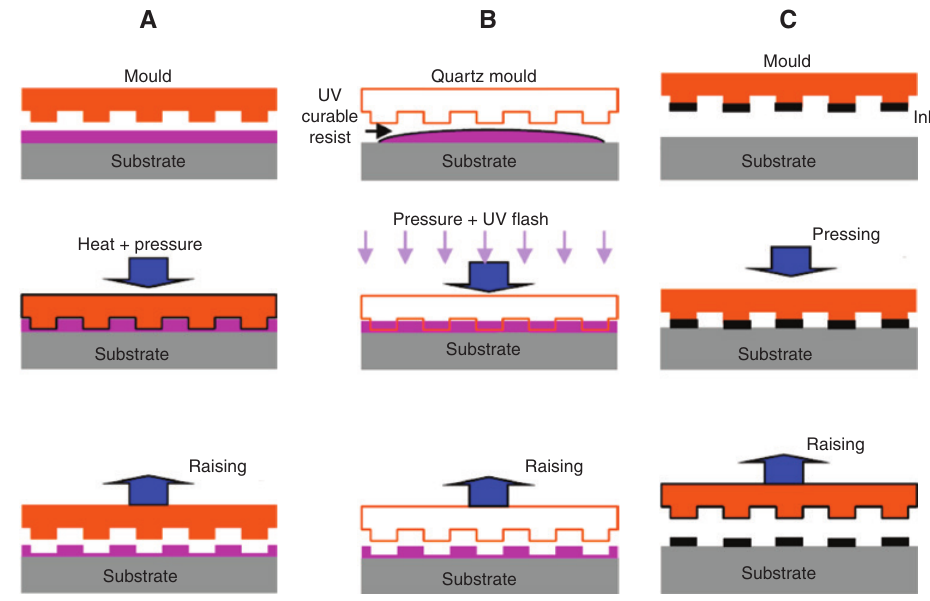
Figure 4: Nanoimprint lithography technology. Schematic diagram of technological processing of (A) thermal NIL, (B) UV-curable NIL and (C) micro/nano-contact NIL (reprint with permis- sion Ref. [54]; Copyright 2015 Springer-Verlag Berlin